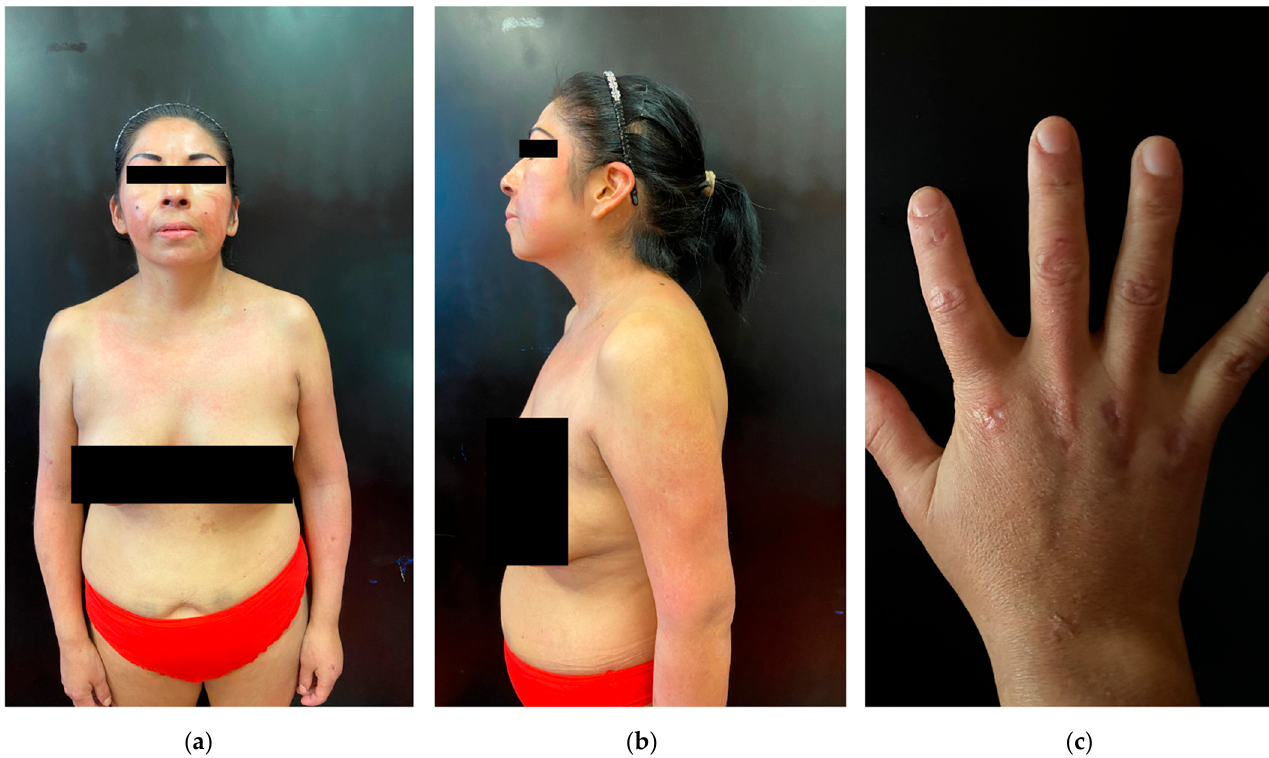
Figure 2. Clinical pictures of the patient after three weeks of therapy ( a ) marked improvement of edema and skin appearance with persistence of V-sign; ( b ) Gottron’s sign; ( c ) reduction of the left-hand edema with persistence of Gottron’s papules.